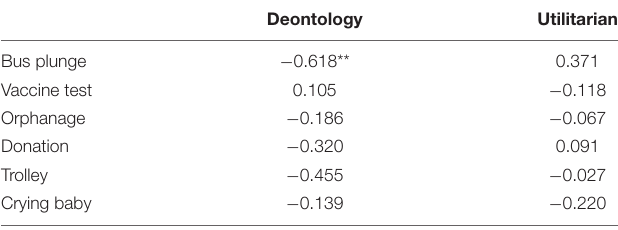
TABLE 3 | Rank correlation between IAcc and reaction time for each moral choice.